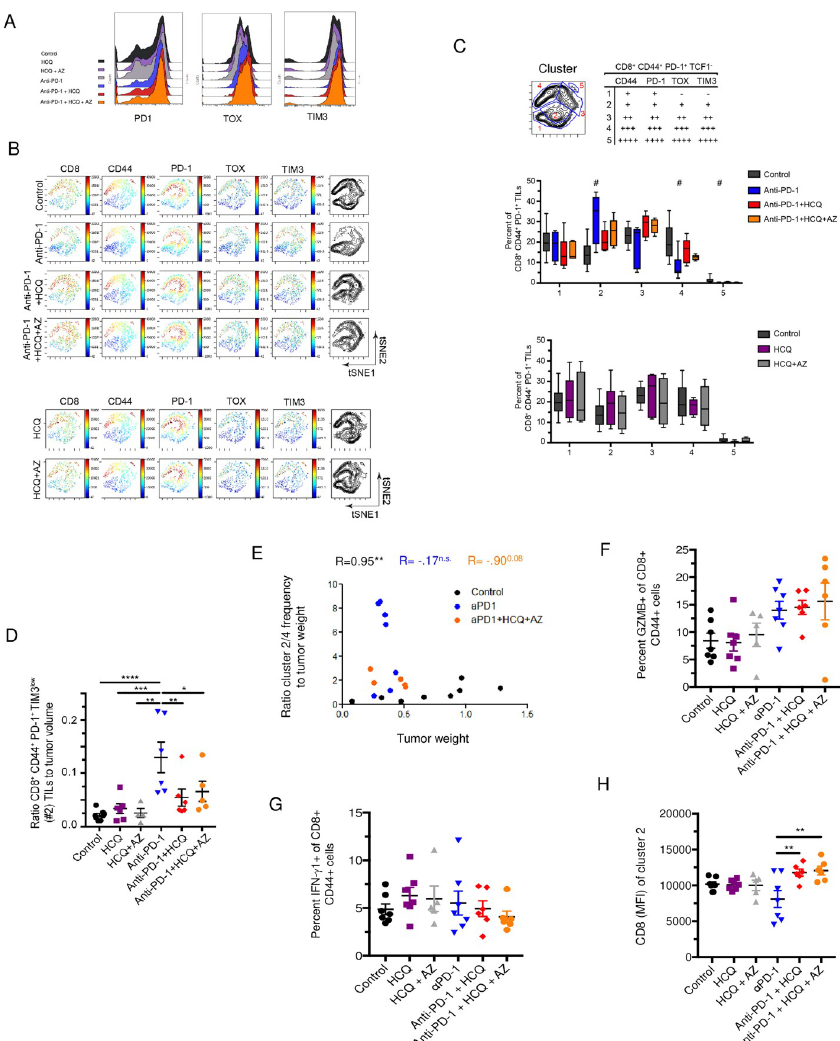
Fig 4. The expansion of specific CD8 + TCF-1 - CD44 + PD-1 + subsets in response to anti-PD-1 is inhibited by HCQ and AZ. Panel A: Histogram profiles of anti-PD-1, TOX and TIM3 staining. Panel B: viSNE analysis of CD8, CD44, PD-1, TOX and TIM-3 expression of CD8 + CD44 + PD-1 + TILs. TCF1 + subsets have been removed. Panel C: tSNE subdivision into different clusters based on expression levels of CD44, PD-1, TOX and TIM3. Upper panel: Table shows how clusters were grouped together. Middle panel: Histogram showing changes in the representation of different clusters in response to anti-PD-1 alone or in combination with HCQ and AZ. Lower panel: Histogram showing changes in the representation of different clusters in response HCQ and HCQ/AZ. Panel D: Ratio of cluster 2 relative to tumor volume. Anti-PD-1 induced an increase in CD8 + effectors which was inhibited by HCQ and HCQ/ AZ. Panel E: Figure showing the ratio of cluster2/4 to tumor weight. Panel F: Percent of GZMB + cells within the CD8 + CD44 + PD-1 + TIL population. Panel G: Percent IFN γ + cells within the CD8 + CD44 + PD-1 + TIL population. Panel H: CD8 expression (MFI) on cluster 2